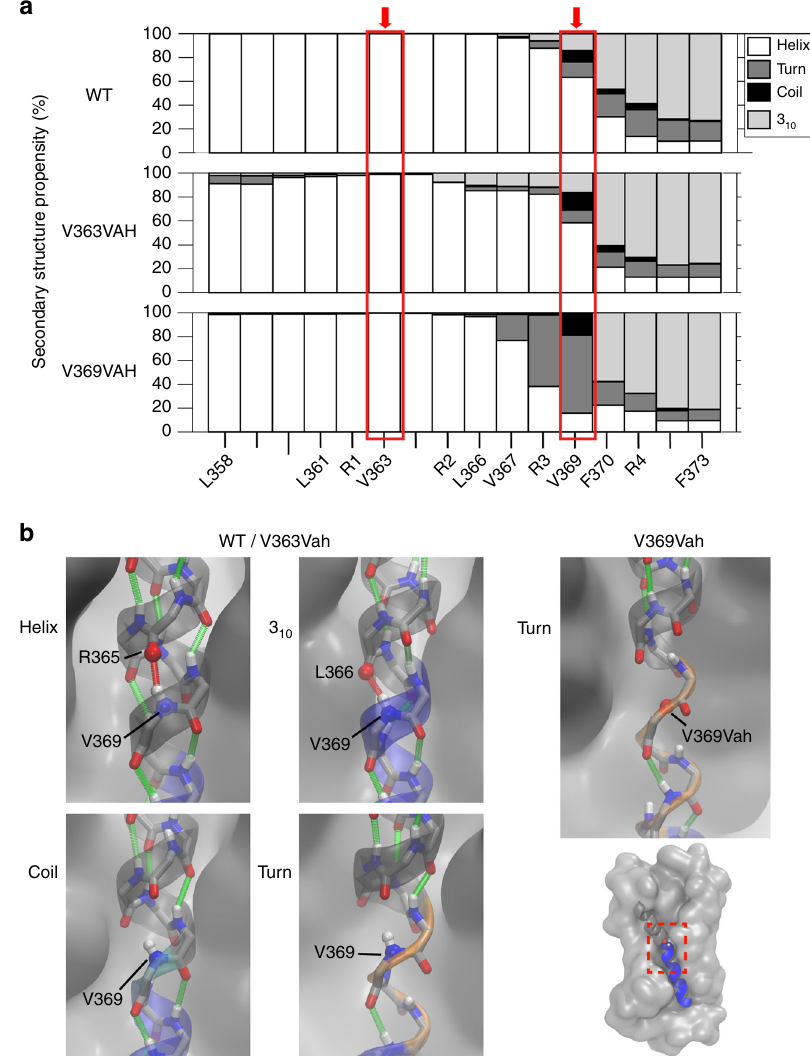
Fig. 5 Simulations identify secondary structure sampling at the S4 transition region. a Helical content of the S4 segment for WT, V363Vah, and V369Vah shown on top, middle, and bottom panels, respectively. Main-chain structure at V363 and V369 highlighted by red boxes. Top, WT S4 maintains the α - helical (white) and 3 10 elements at the N- and C-termini, and highlights helical sampling at V369 — the transition point. Middle, V363Vah recapitulates WT S4 structural elements. Bottom, V369Vah displays a localized loss of helical structure. b Representative snapshot images from the simulations for WT, 363Vah (left), and 369Vah. Main-chain structure is represented by the transparent cartoon overlay and main-chain H-bonds are indicated by red and green